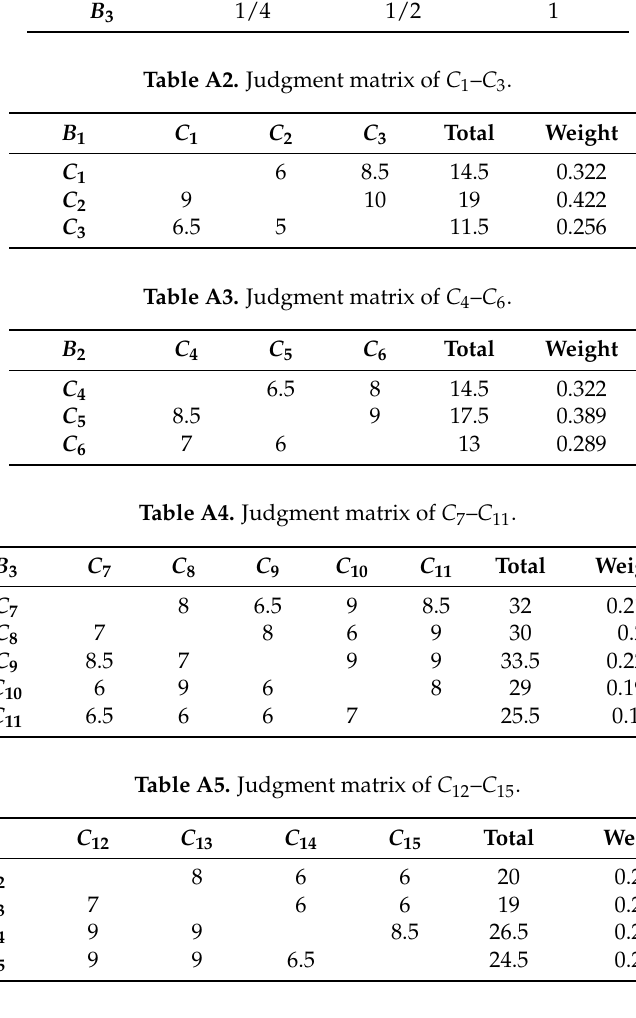
Table A6. Judgment matrix of C 16 – C 17 .